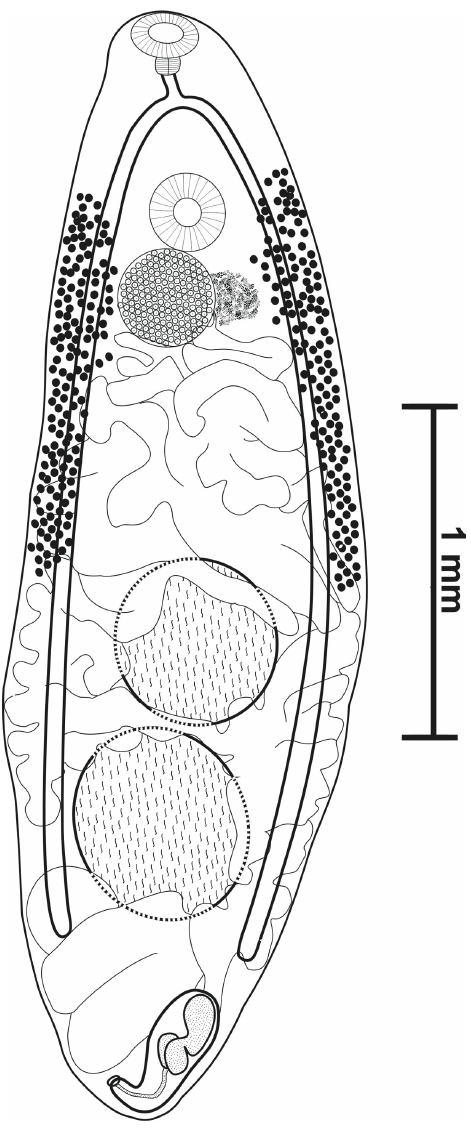
Figure 1 - Urotrema macrotestis Mané-garzón and Telias 1965 found in Eumops glaucinus (Wagner,